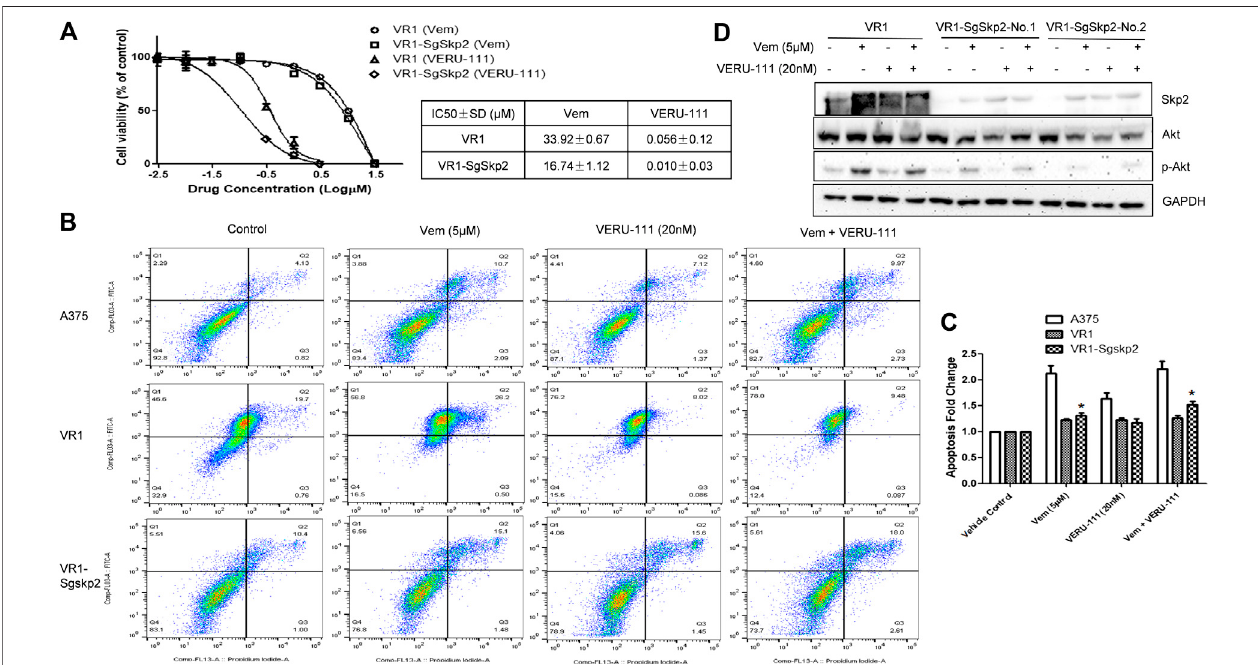
FIGURE 3 | Knockout of Skp2 restore drug sensitivity of Vem-resistant cell to Vem and VERU-111 (A) Skp2 guide RNA (SgSkp2) was introducced to VR1 cells to make stable Skp2 knockout clones (VR1-SgSkp2). IC 50 was measured upon indicated treatment using MTS assay (B) Apoptosis of VR1 and Skp2 knockout VR1 cells upon treatment. Data was analyzed by Flowjo 10.4 software. In order to compare apoptosis, we fi xed gate in three cell lines, as quanti fi ed in (C) *, p < 0.05, compared with VR1 cells (D) De fi cient of Skp2 eliminating AKT expression, which paralled with decreased p-AKT.